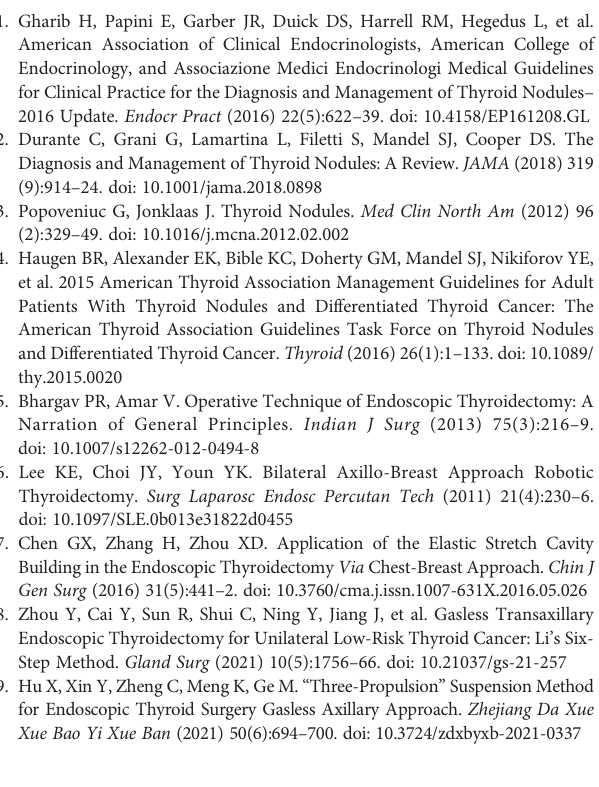
Supplementary Figure 1 | The components of the “ elastic stretch cavity builder ” .